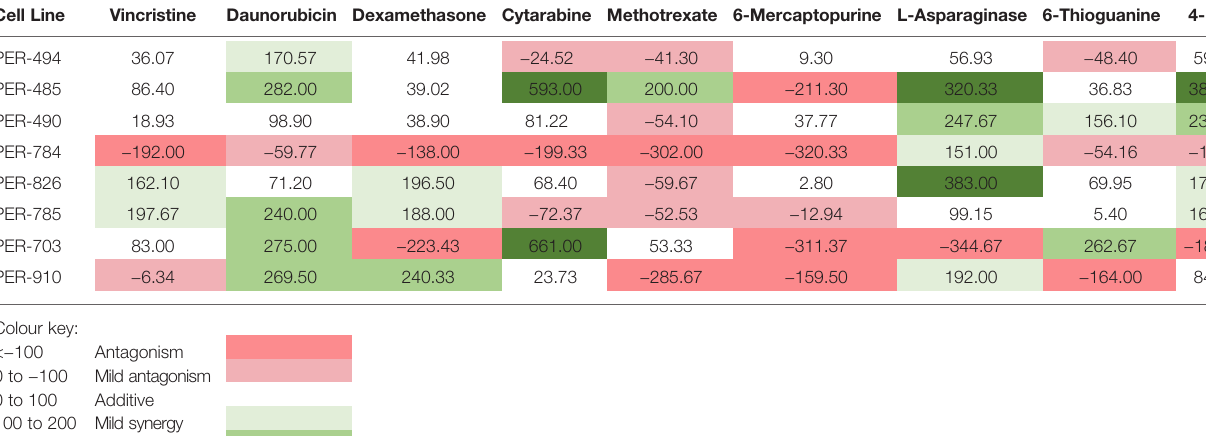
TABLE 4 | Total in vitro synergy scores between car fi lzomib and conventional chemotherapy agents. Cell Line